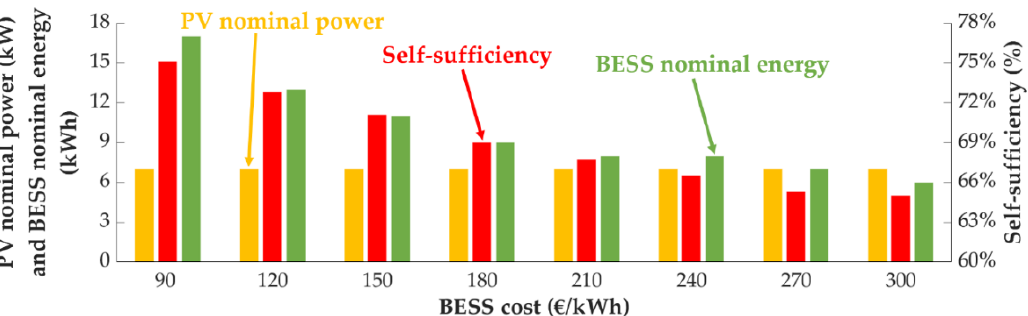
Figure 14. PV nominal power, BESS nominal energy, and maximum SS for different BESS costs.